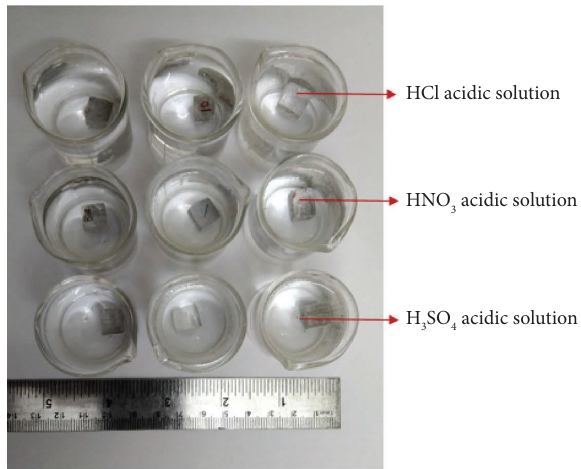
Figure 2: Composite samples immersed in acidic